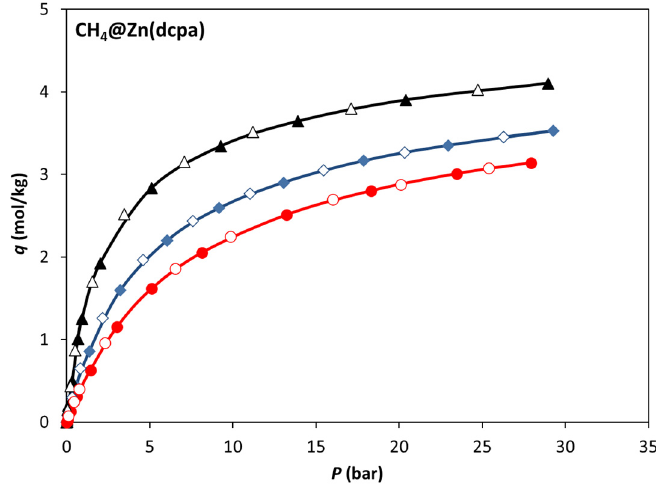
Figure 6. Absolute adsorption equilibrium isotherms of CH 4 on Zn(dcpa) at 273 K ( ▲ ), 303 K ( ♦ ), and 323 K ( ● ). Filled and empty symbols represent adsorption and desorption experimental data, respectively.